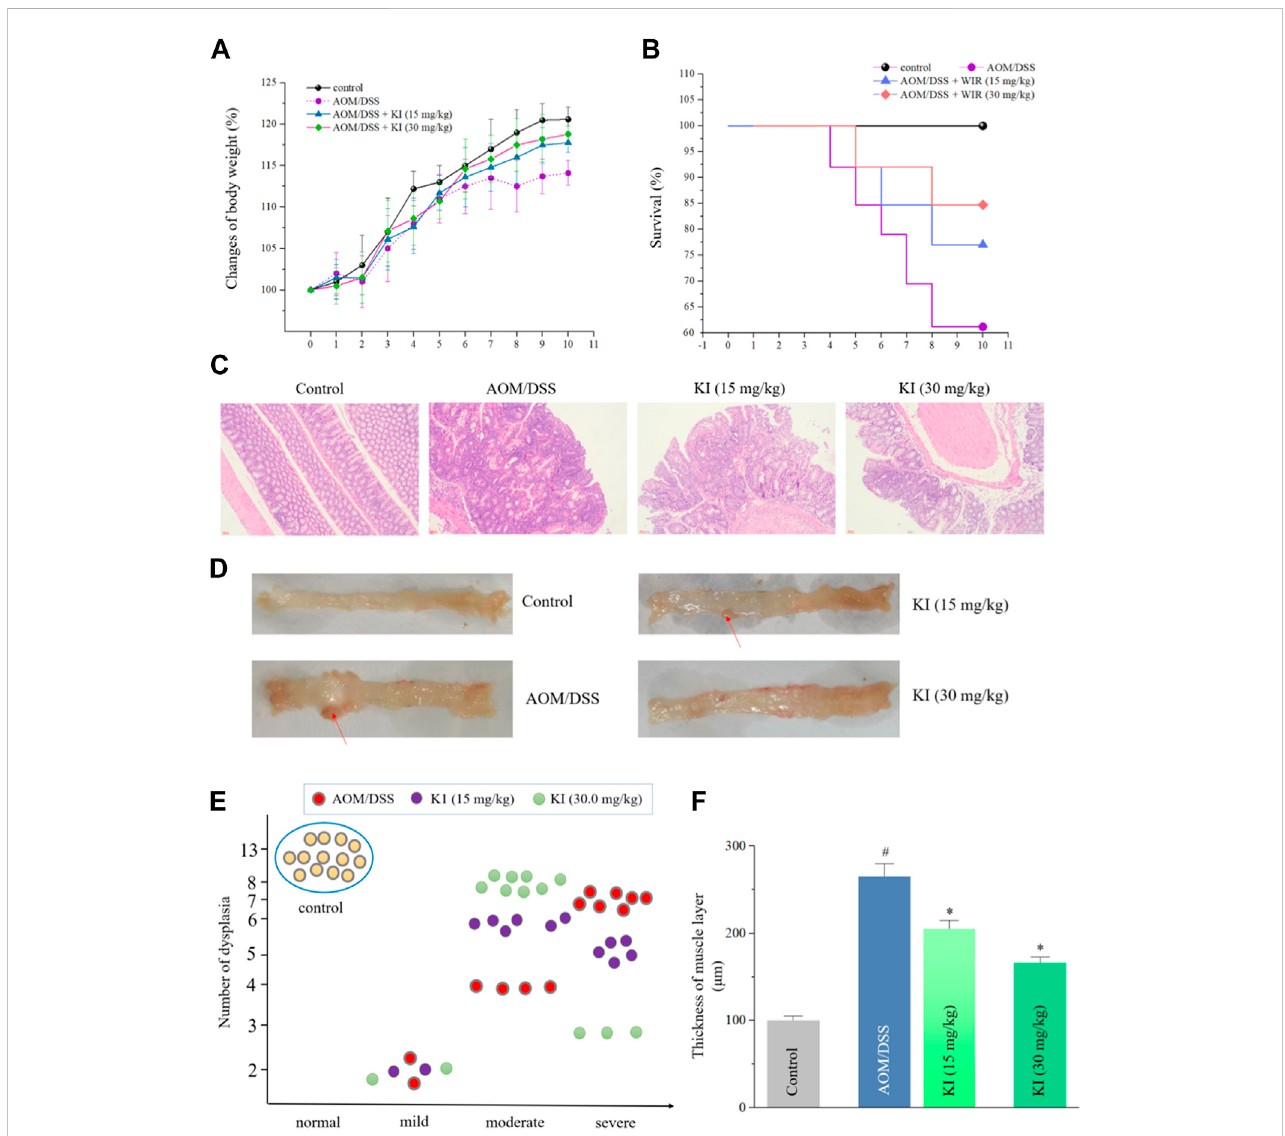
FIGURE 3 In vivo effects of KI on AOM/DSS-induced CAC. (A) Mean body weight (percentage) for each group (n = 13). Values are means ± SD from three separate experiments. (B) The survival rate for each group. (C) Histological changes for each group (× 200). (D) Representative macroscopic features of colon tissues for each group. Red arrows for the dysplasia. (E) Degrees of dysplasia event number (total = 13) for each group. (F) Thickness of muscle layer for each group. Values are means ± SD from three separate experiments. # p < 0.05 compared with the control group; * p < 0.05 comparedwith AOM/DSS